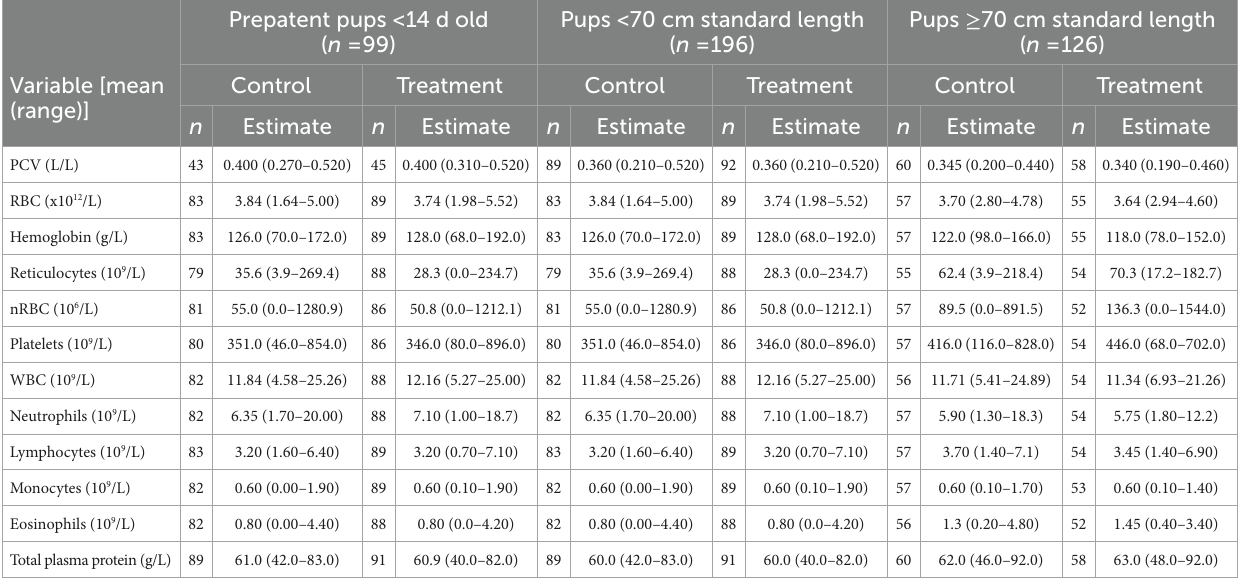
TABLE 2 Recruitment median values (and ranges) of hematological parameters for treatment groups of Australian sea lion pups for each age cohort.